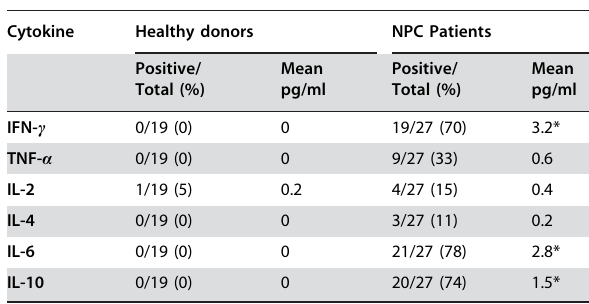
Table 2. Serum levels of Th1 and Th2 cytokines. .. ... .... ... ... .... ... ... .... ... ... .... ... ... .... ... ... .... ... ... .... . Cytokine Healthy